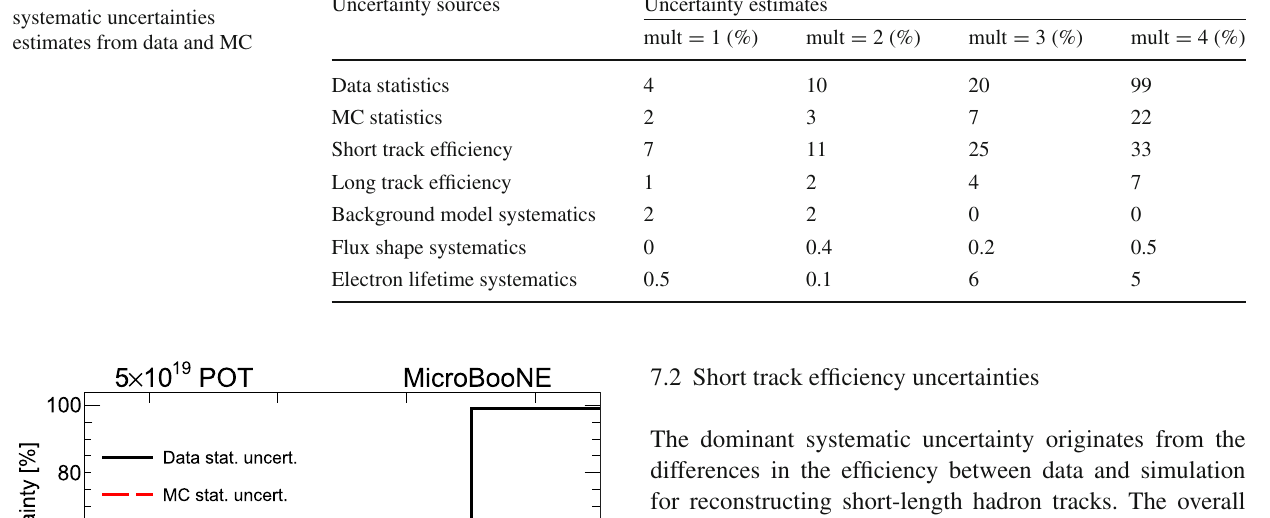
systematic uncertainties estimates from data and MC